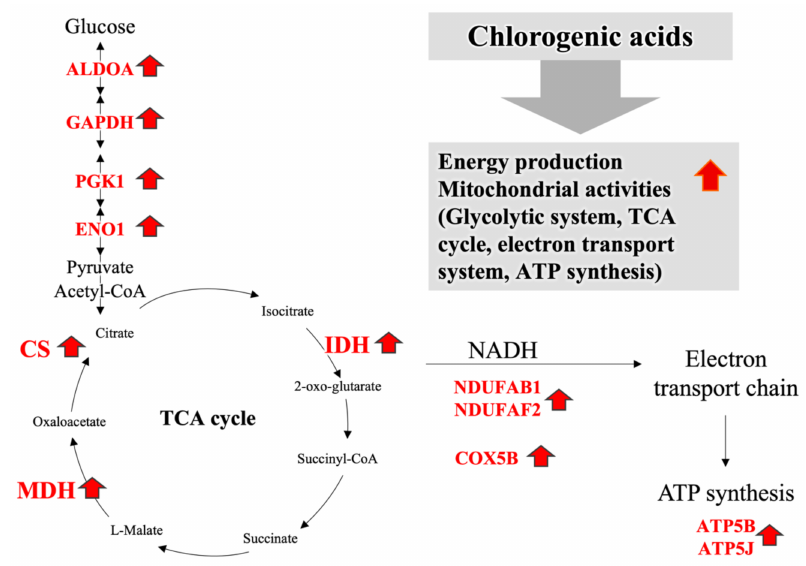
Figure 3. A schematic representation of the proposed mechanism underlying the effects of chlorogenic acid on metabolism as determined by the present in vitro study using HepG2